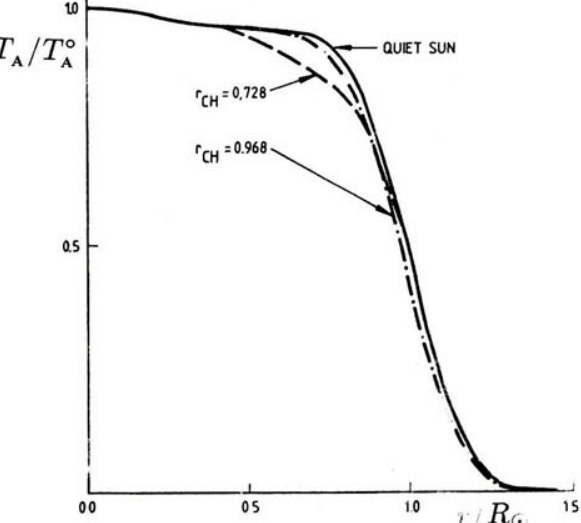
Fig. 8. Simulated radio scans of the quiet Sun and of the SLH witli a coronal hole at the wavelength 31 6 cm (CH if at the distant e ? CH iiom the center of the solar di«k) as a result of tlie convolution of the simulated radio brightness with the RATAV600 beani